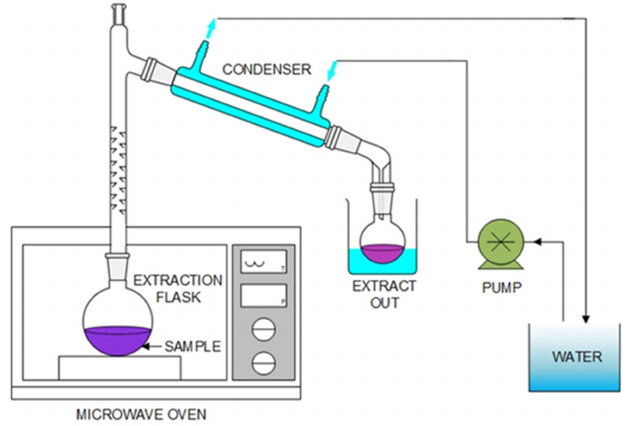
Figure 4. Schematic diagram of microwave-assisted extraction apparatus.